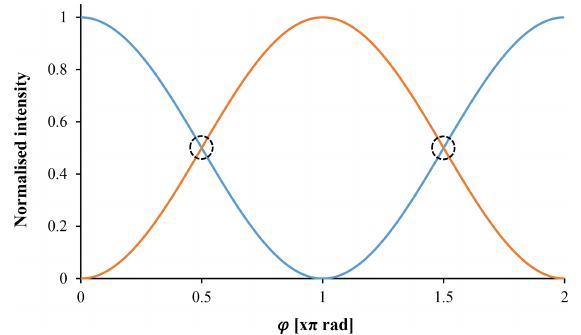
Figure 3. The intensity of light measured by each detector in the interferometer as a function of the interferometric phase. The dashed circles indicate the quadrature points where the light inten- sity falling on each detector is approximately equal. At these points, the relationship between a small phase shift (cid:49)ϕ and the measured intensities is approximately linear, and the sensitivity of the mea- surement is